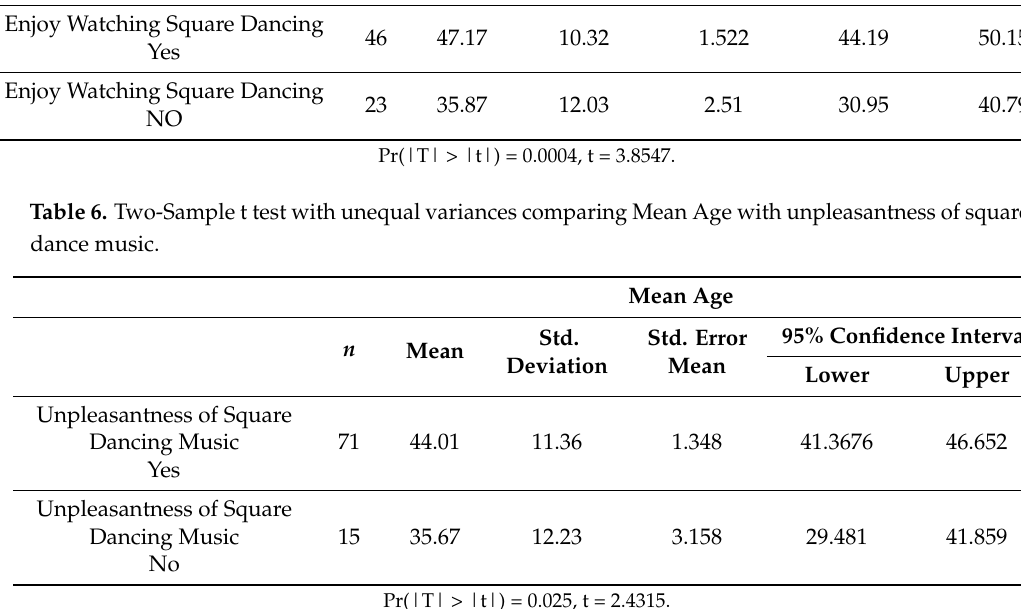
Table 7. Two-Sample t test with unequal variances comparing Mean Age with regularity of square dancing participation.